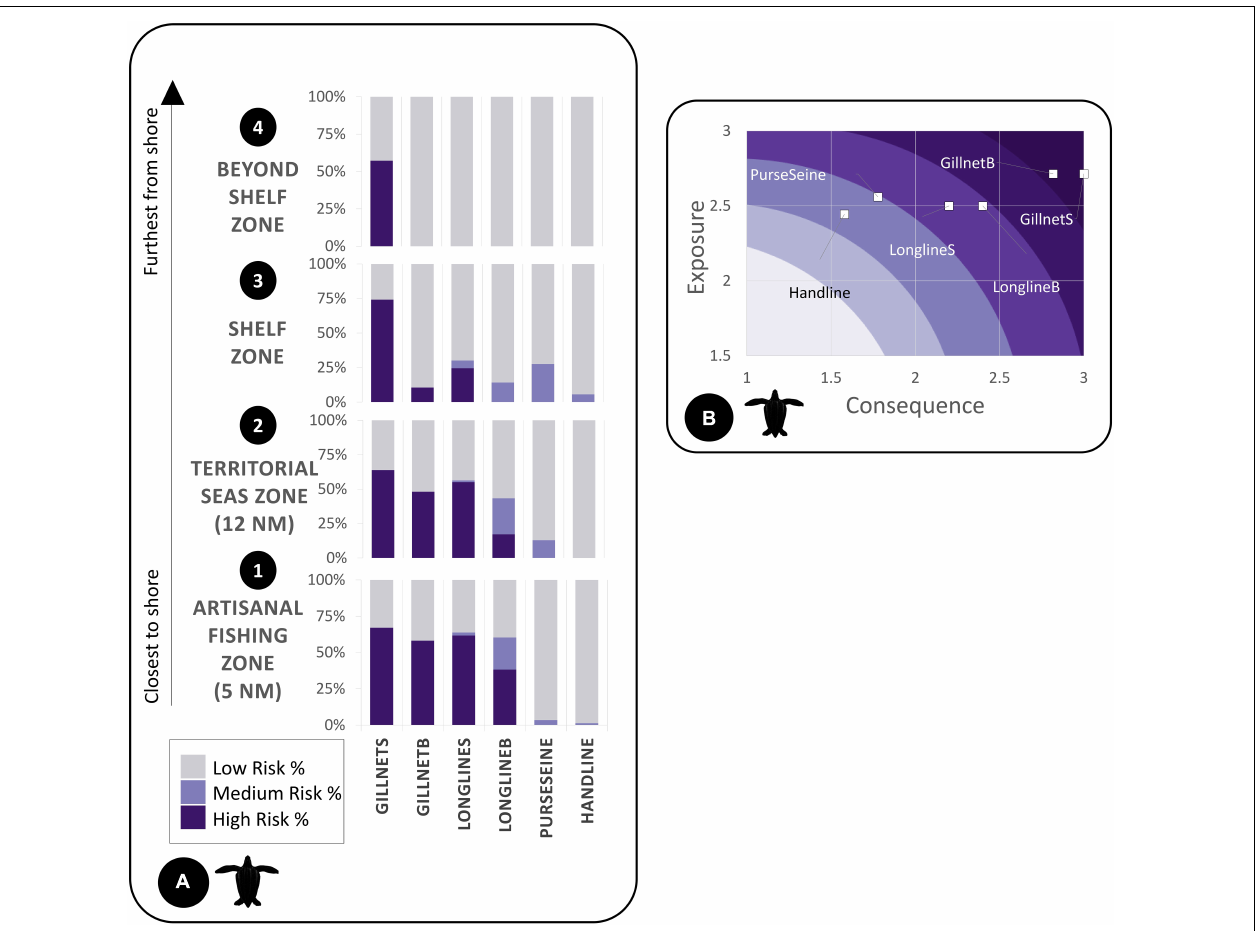
FIGURE 6 | (A) We calculated bycatch risk percentages for leatherback turtles for each subzone by gear type divided into low, medium, and high risk. (B) Exposure and consequence plots depict gear impact on species based on the spatial exposure or consequence criteria ratings ( Supplementary Material ).